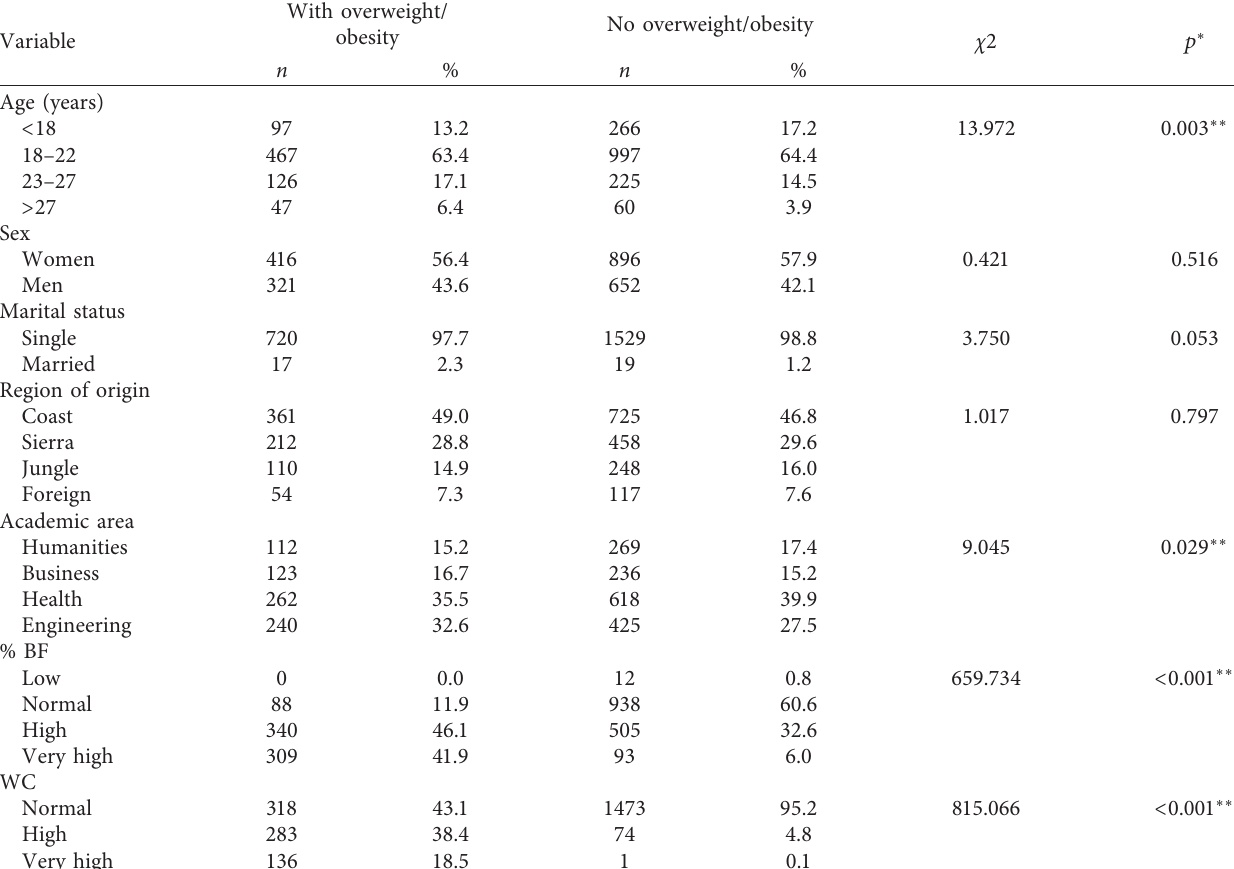
Table 5: Analysis of the association between sociodemographic characteristics and overweight/obesity in university students. Variable